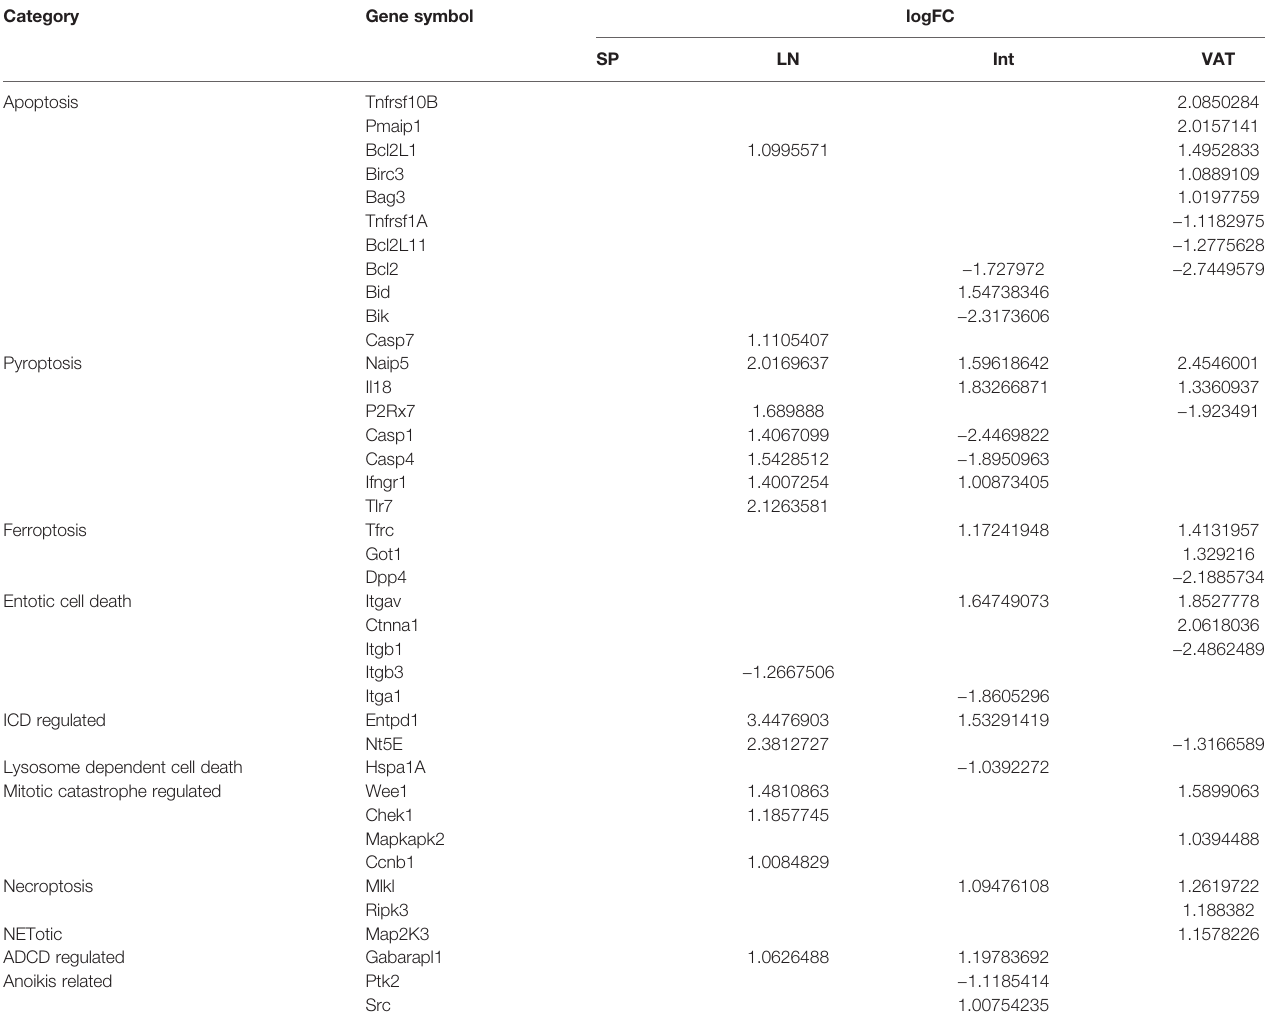
TABLE 7B | Expression modulation of cell death-associated genes showed a tissue-speci fi c